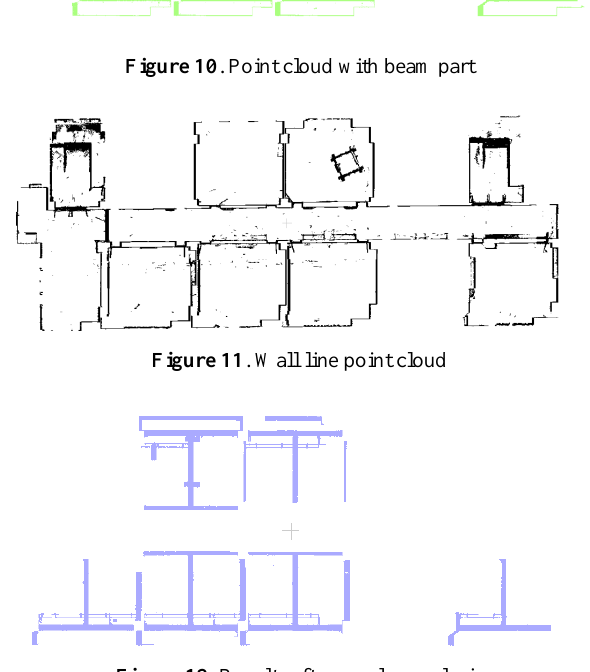
Figure 12 . Results after overlay